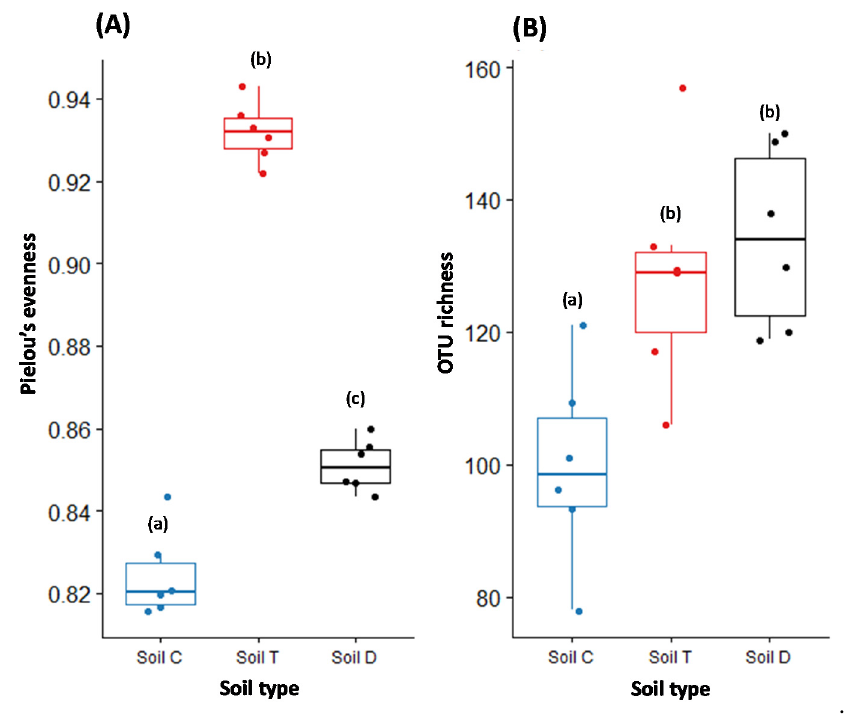
Figure 1. Box plots showing Pielou’s evenness ( A ) and the OTU richness ( B ) of fungal communities. The lower and upper boundaries of each box enclose 25% ± 75% of the data. The line within the box shows the median value, and the bar lines above and below the boxes indicate minimum and maximum values ( n = 6). Points display raw data. Different small letters, shown in parentheses, indicate significant differences between values (ANOVA followed by Tukey test; p -value < 0.05).